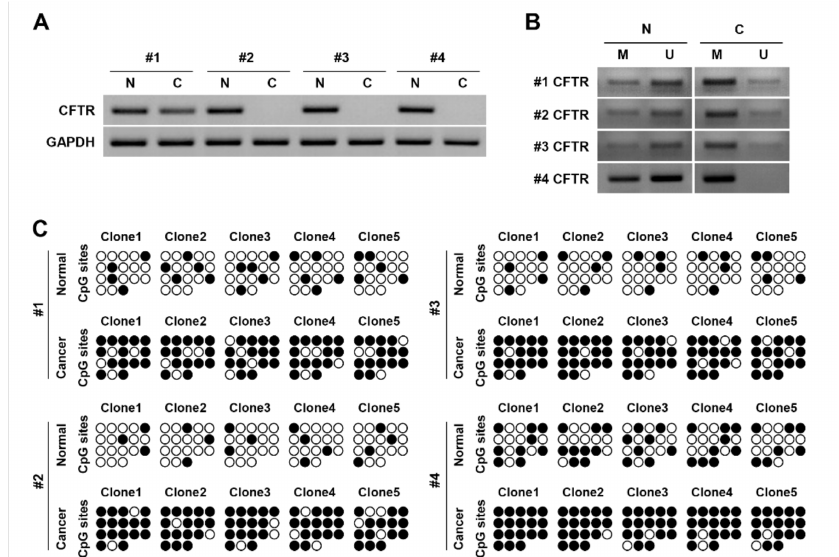
Figure 4. CFTR deficiency and CpG island hypermethylation in HNC patient tissues. ( A ) Total RNA was extracted from four pairs of normal tissues and head and neck cancer tissues, and RT-PCR was used to determine expression levels of CFTR in HNC. CFTR expression was decreased #1 or highly deficient #2–4 in cancer tissues, while CFTR was highly expressed in normal tissues. Cancer tissue, C; normal tissue, N. ( B ) Methylation of CFTR was analyzed by MSP. A CFTR methylated band was strong in cancer tissues while a CFTR unmethylated band was relatively strong in normal tissues ( C ) Bisulfite genomic sequencing of CpG islands of CFTR was performed in cancer and normal tissues. (unmethylated cytosine: open circle, methylated cytosine: closed circle) CpG island hypermethylation of CFTR was apparent in cancer tissue. All experiments were performed in